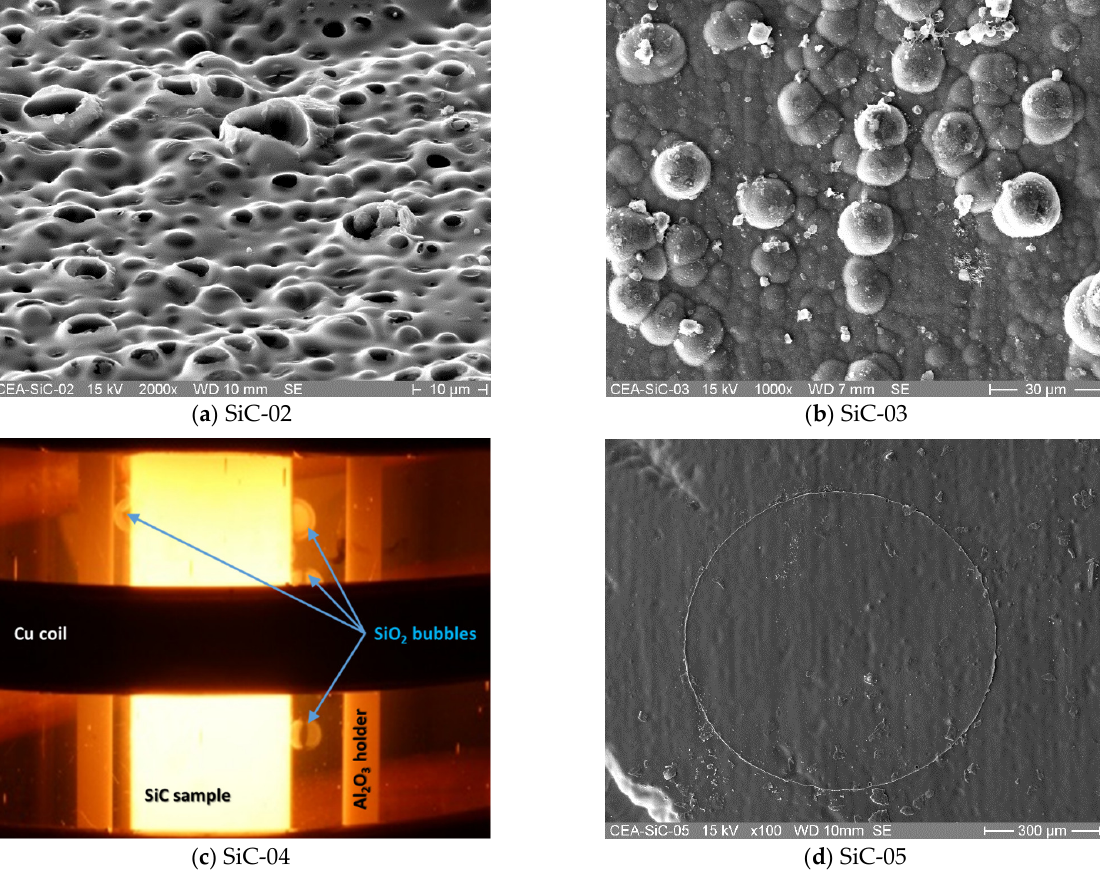
Figure 9. Bubble formation at oxidized SiC surfaces: SEM images ( a , b , d ) and video snapshot taken during test SiC-04 ( c ).